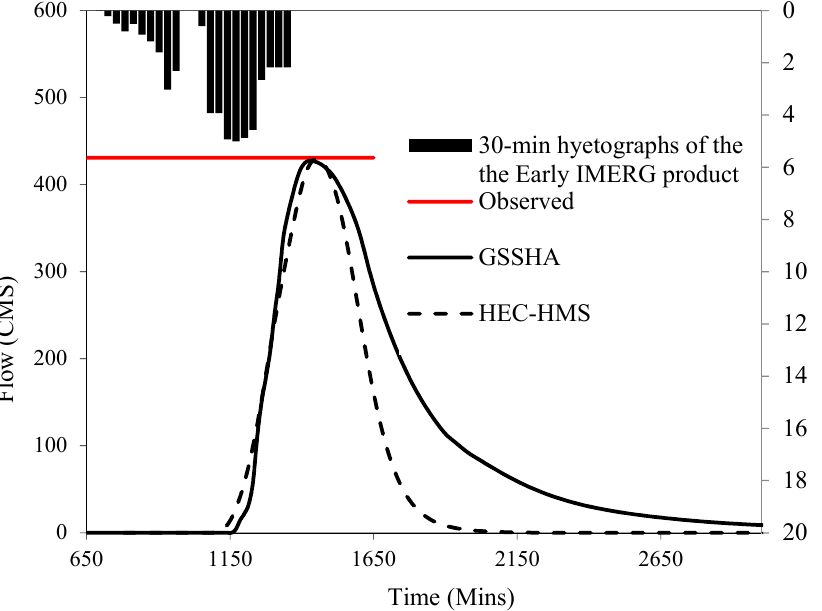
Figure 12. Comparison between calibrated hydrographs for HEC-HMS and GSSHA models and observed peak discharge at the outlet of Wadi Al-Nu’man.